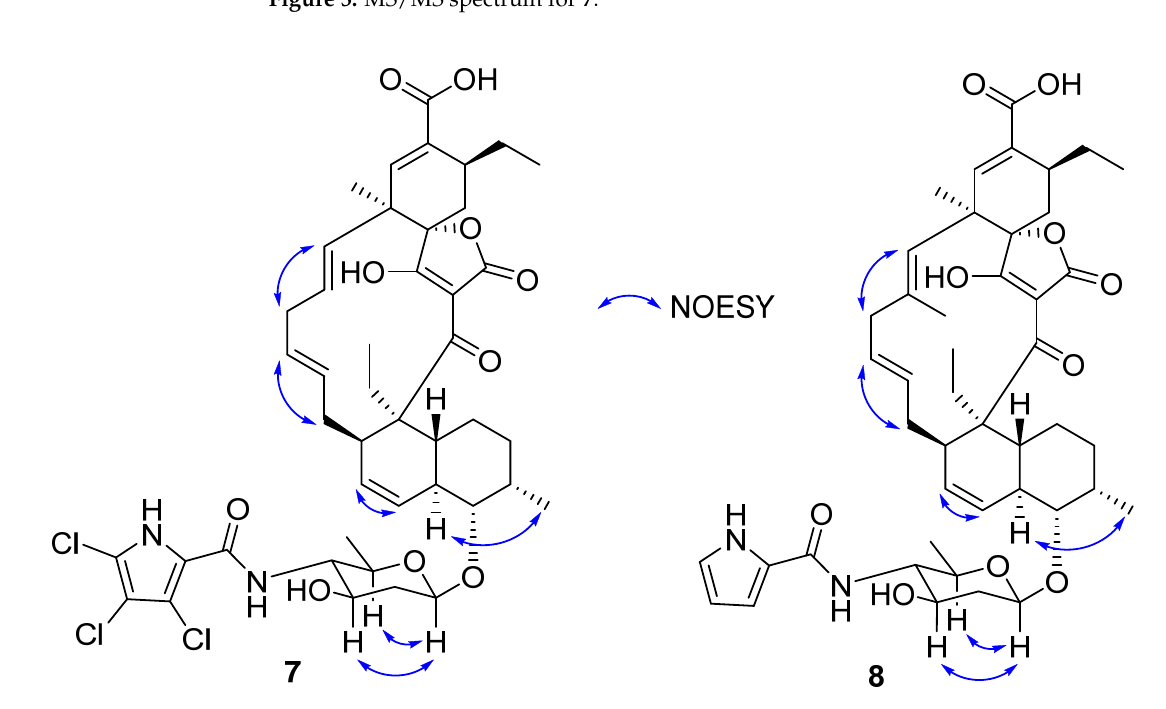
Figure 5. Selected NOESY correlations for 7 and 8 . Figure 6. Selected NOESY correlations for 7 and 8